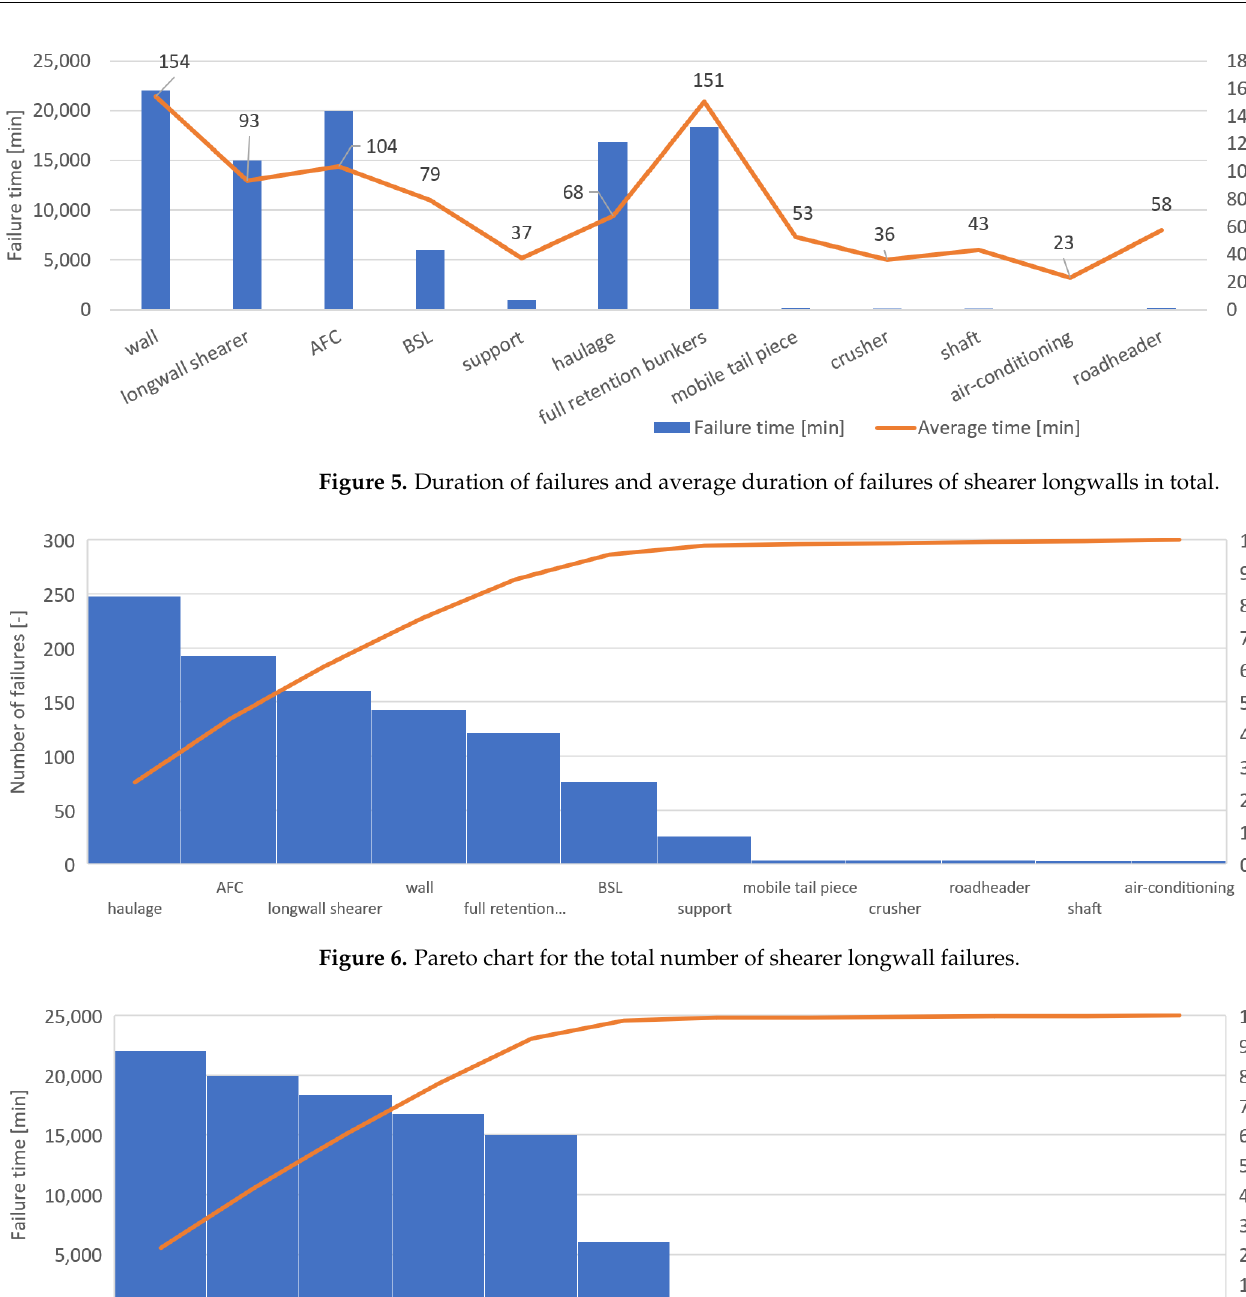
Figure 4. Number of failures and average duration of failures of shearer longwalls in total.